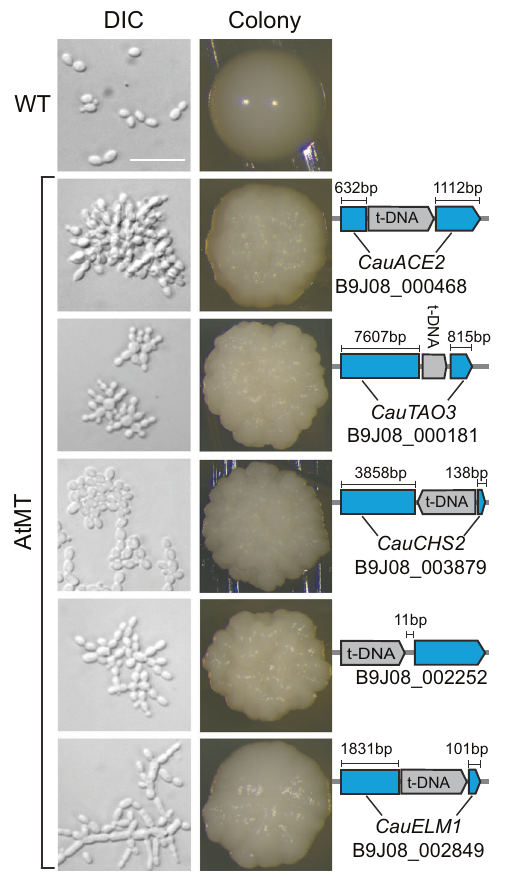
Fig. 2 Transgene insertion sites associated with C. auris morphogenic mutants. Cell (DIC microscopy, Differential Interference Contrast) and colony morphologies demonstrate distinct morphogenic defects in fi ve AtMT ( Agrobacterium tumefaciens -mediated transformation) insertional mutants (bottom) compared to wild-type C. auris AR0382 (top). Identi fi ed transgene insertion sites were con fi rmed using Sanger sequencing (right). In all fi ve cases, T-DNA insertion events were not accompanied by any additional insertions or deletions in the insertion locus. Scale bar = 20 μ